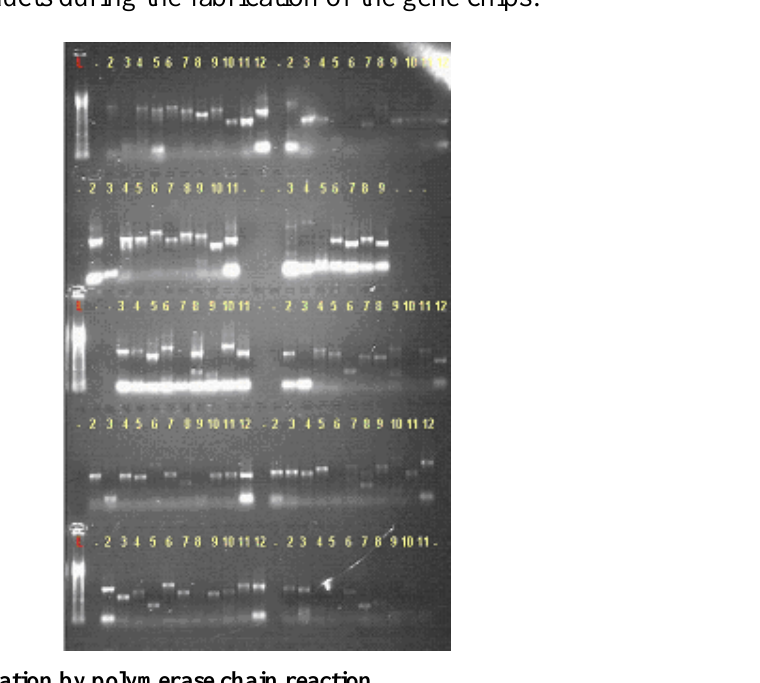
Figure 4: Gene amplification by polymerase chain reaction. This plate represents a selection of the resulting DNA bands generated after amplifying selected genes from the 15K Mouse Gene Set via PCR. The first column shows a DNA ladder used to allow size estimation of the individual